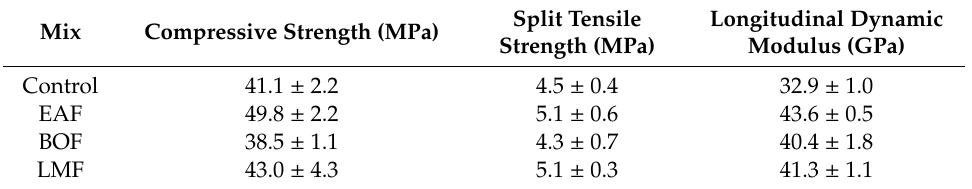
Table 6. Twenty-eight-day mortar properties (average ± standard deviation) for four equivalent mixes with full replacement of aggregate with matched gradations of dolomite (control), EAF slag, BOF slag, or LMF slag